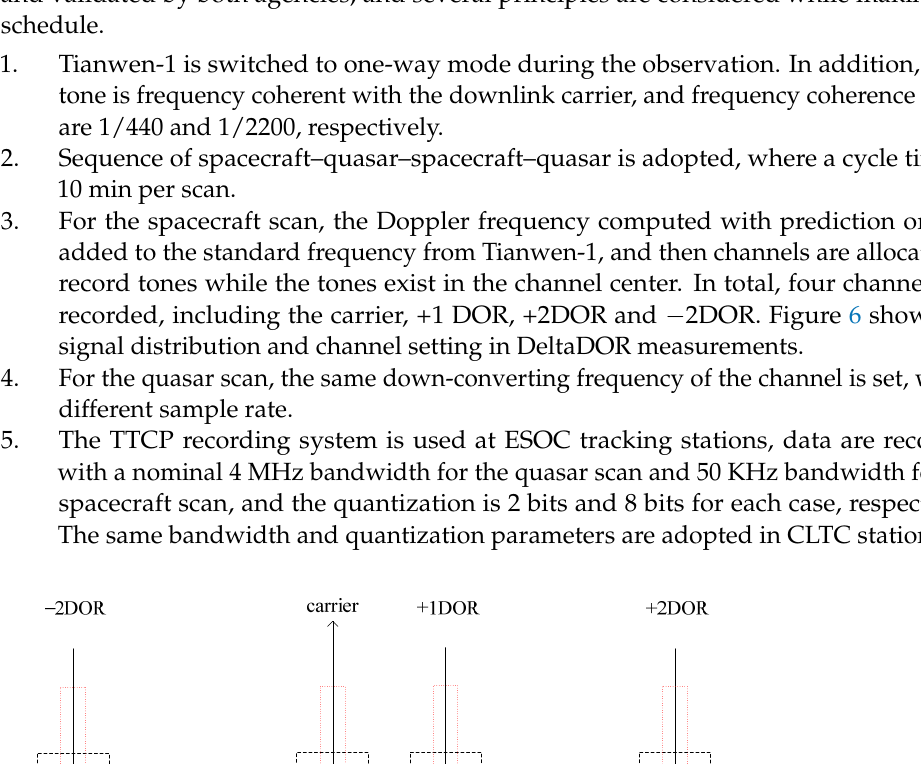
Table 1. Computation burden of the two methods in each iteration.